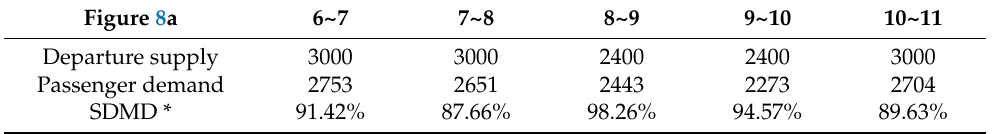
Table 12. Details of supply and demand matching degree of multi-cycle timetable in scenario 3. Figure 8a